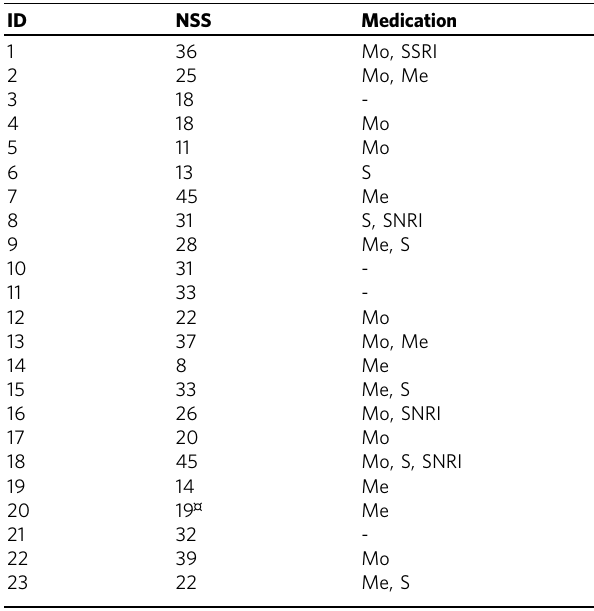
inhibitor, ¤ excluded for corrupted magnetic resonance encephalography